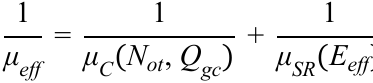
) plotted as a function of the gate voltage at V ds ) for increasing total dose levels up to eff